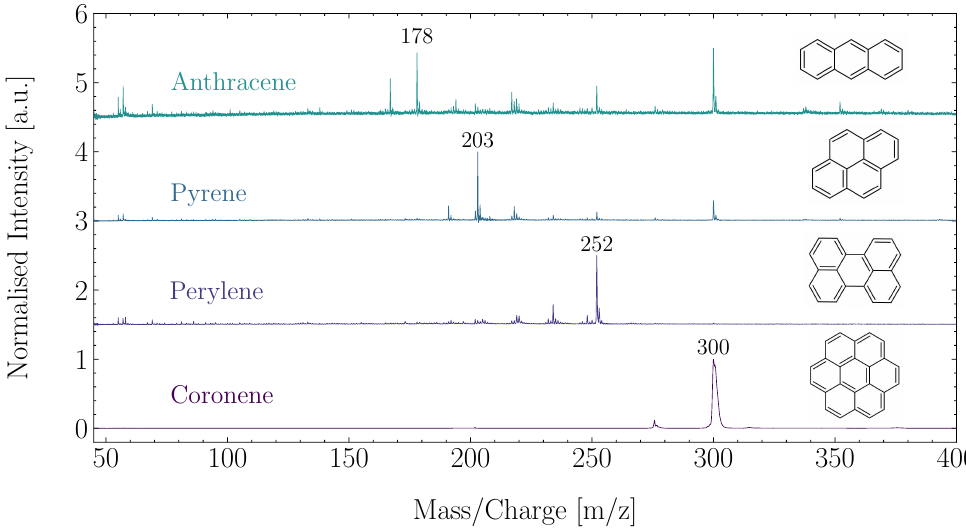
Figure 3. Measurement of four representative PAHs with ORIGIN, measured at a laser pulse energy of 4 µ